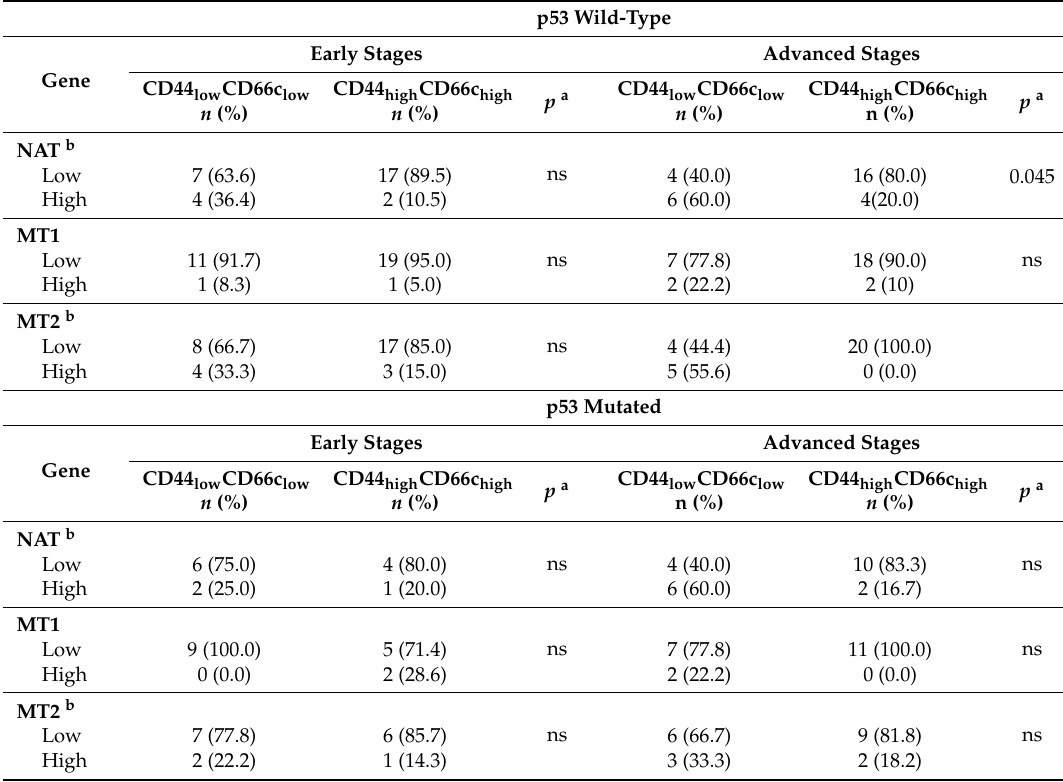
Table 2. Relationship between cancer stem cell CSC markers and melatonin synthesis and signaling genes according to p53 status and progression of the